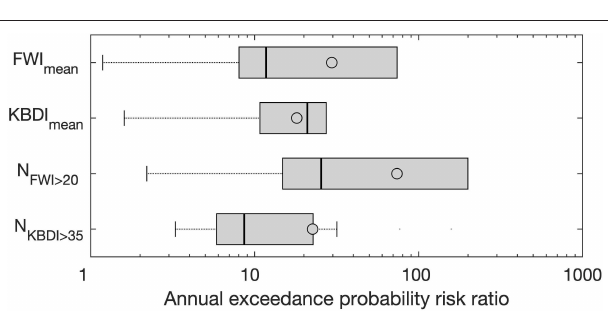
FIGURE 5 | Annual exceedance probability risk ratio of a 2003-like year across the Mediterranean region between observations with the fitted trend to 2017 and counterfactual observations for different FWI and KBDI attributes. The boxplots indicate the range of changes obtained from different counterfactual observations as deduced from different GCMs. This is slightly different from Figure 4 where counterfactual observations were deduced from the multimodel mean of the 17 GCMs. Boxes indicate the inter-quartile range, vertical thick lines indicate the median and circles indicate the